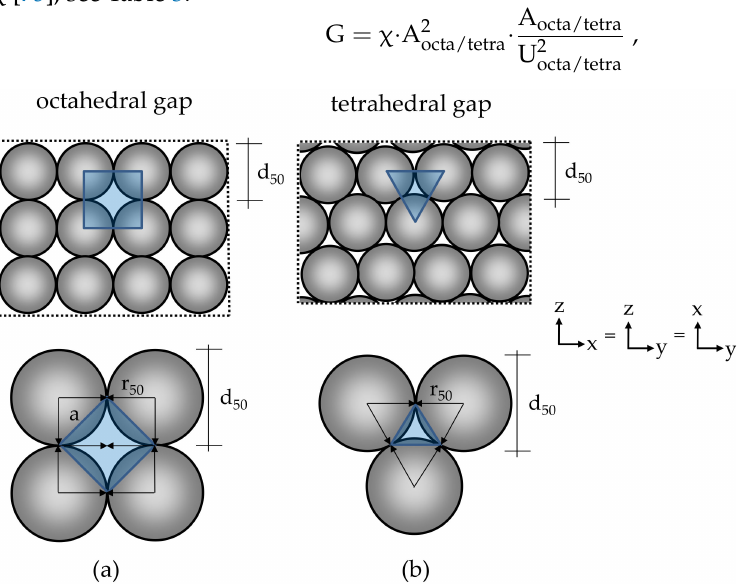
Figure 10. Sphere packing with ( a ) octahedral and ( b ) tetrahedral gaps; Top: Cross section of sphere packing with gaps; Bottom: Detailed view of a gap between the particles (gray); a: Side length of the triangle; d 50 : Medium grain size (diameter); r 50 : Halved medium grain size (radius). Table 3. Values of the form factor χ for different cross sections of the pore according to [75]. χ Shape of the Cross Section of the Pore - - 0.5 Circular shape